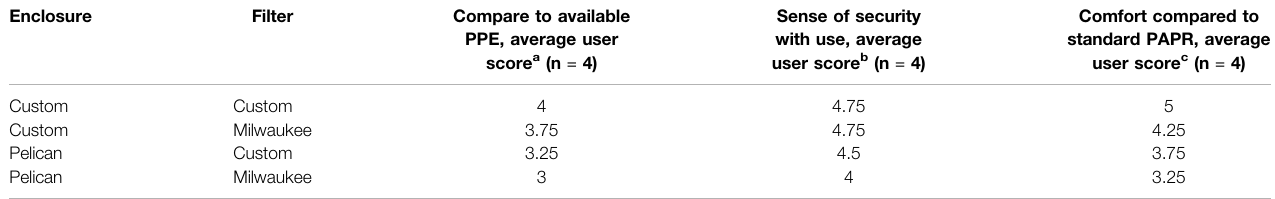
TABLE 4 | Clinical feedback survey results. Score averaged among four users. Enclosure Filter Compare to available